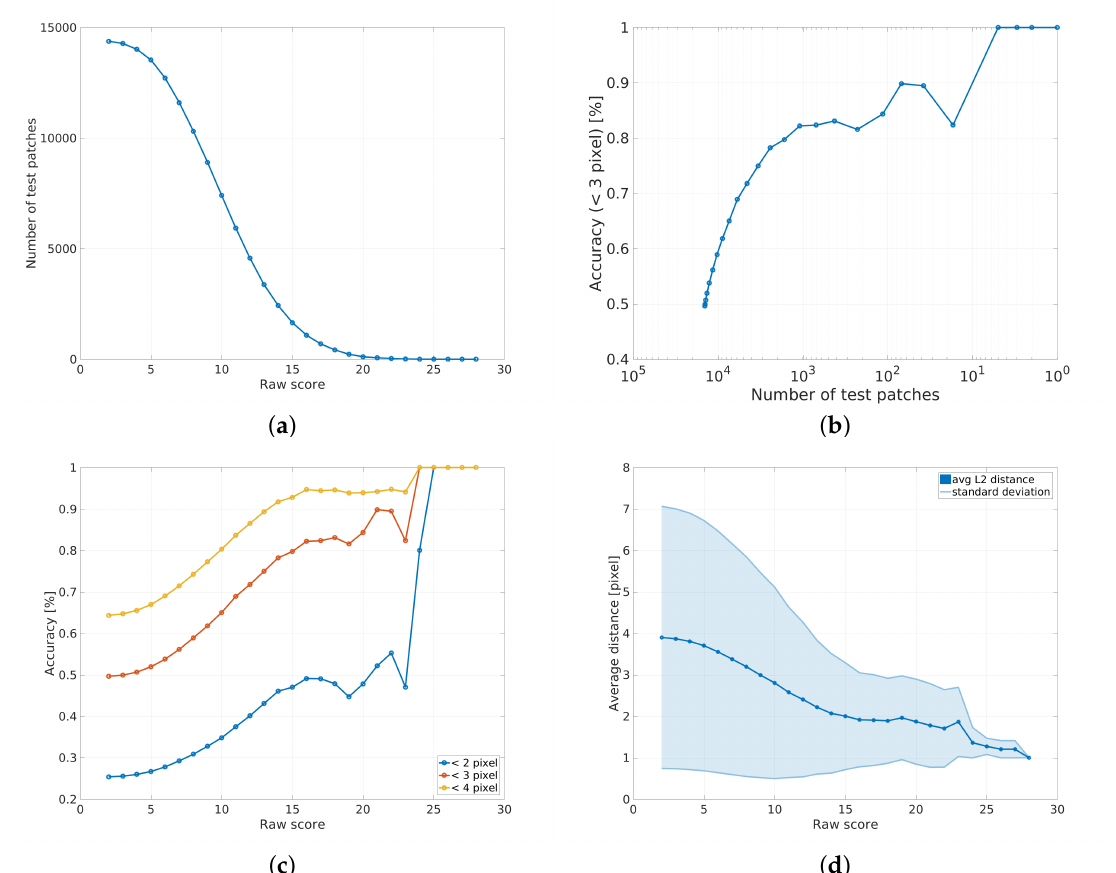
Figure 5. Illustration of influence of the raw score as a threshold: ( a ) the relation between the predicted score and the number of patches; ( b ) relation between the number of patches and the matching accuracy; ( c ) relation between the predicted score and the matching accuracy; and ( d ) relation between the predicted score and the average distance ( L 2 ) between the predicted matching points and the ground truth location. The matching accuracy in Figure 5b is measured as the percentage of matching points, where the L 2 distance to the ground truth location is less than three pixels and in Figure 5c less than 2, 3 and 4